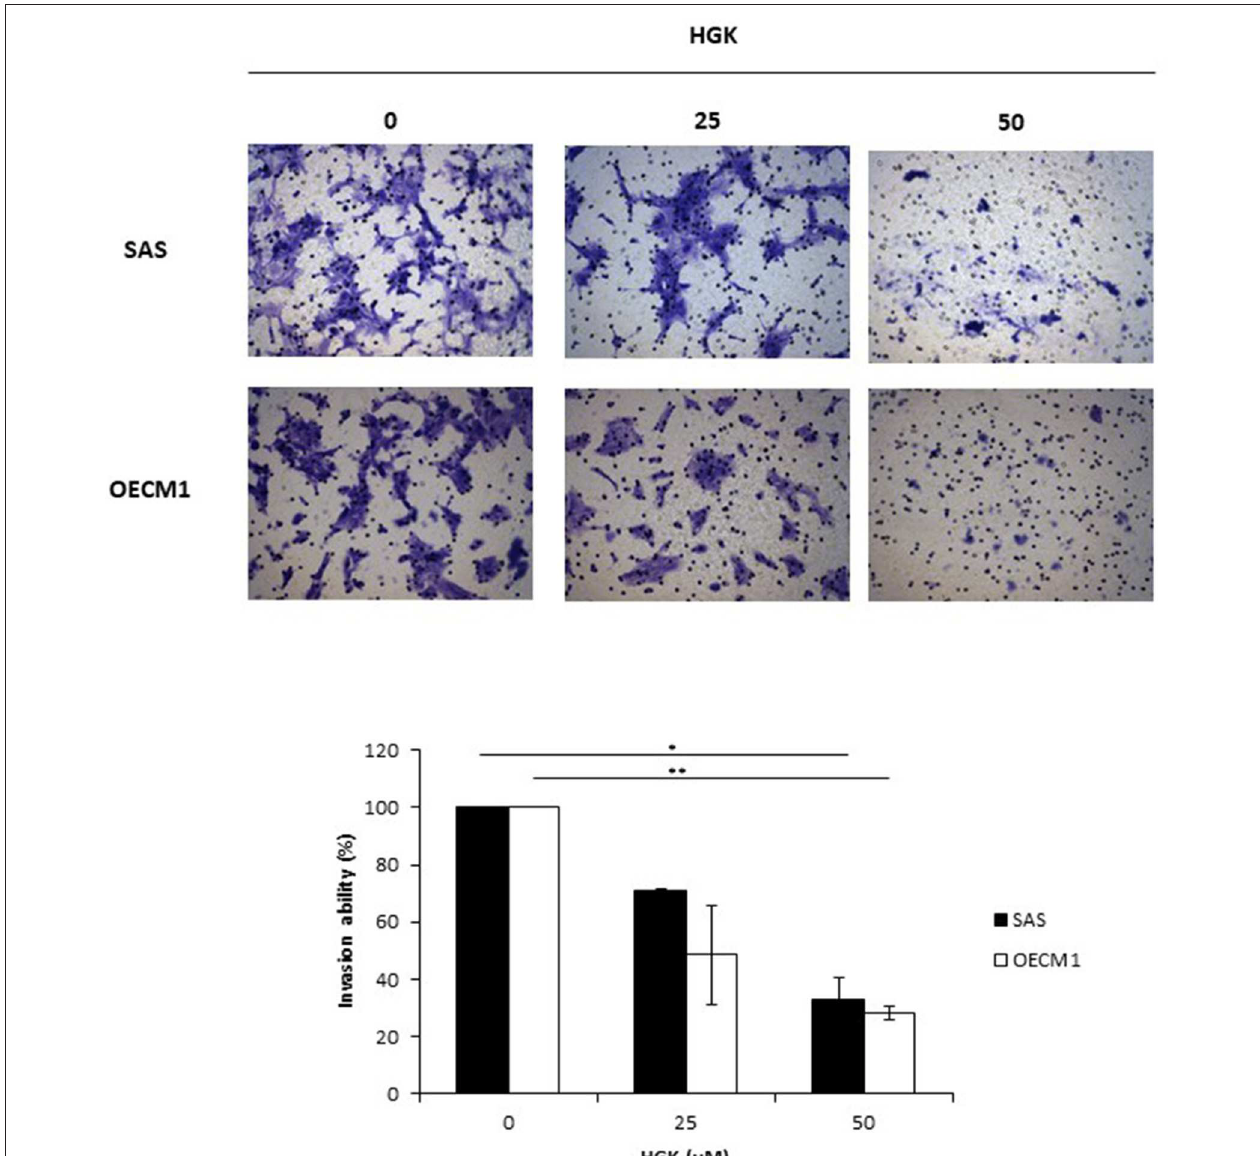
FIGURE 6 | Effects of HGK on cell invasion in SAS and OECM1 cells. SAS and OECM1 cells were treated with 0, 25, 50, 75 µ M HGK for 24h. The results are shown as the mean ± S.E. of three independent experiments. * P < 0.05 and ** P < 0.01.